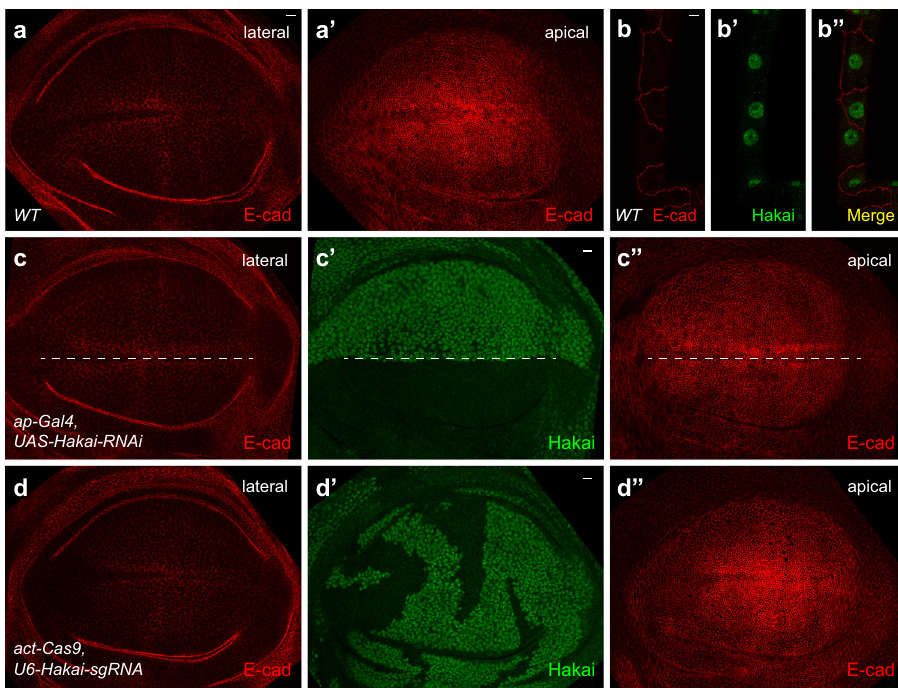
Fig. 5 Hakai does not mediate E-cadherin levels in wing discs. a – a ’ Lateral ( a ) and apical ( a ’ ) section of E-cadherin staining in wild-type wing-disc epithelia. b – b ” E-cadherin is mainly localized in the cell membrane ( b ), while Hakai is mostly in the nucleus ( b ’ ) in the large tracheal cells. c – c ” Expression of Hakai RNAi in the dorsal half of the disc (below the dashed line) using ap-Gal4 led to a strong reduction of Hakai ( c ’ ), but E-cadherin staining was not affected either laterally ( c ) or apically ( c ” ). d – d ” Lateral ( d ) and apical ( d ” ) E-cadherin distribution is not changed in Hakai mutant clones marked by the absence of Hakai staining ( d ’ ), when crossing actin-Cas9 with U6-Hakai-sgRNA . The experiments in a-d ” were repeated at least twice independently with similar results, and each time around 30 wing discs for any genotype were examined. Scale bars: 10 μ